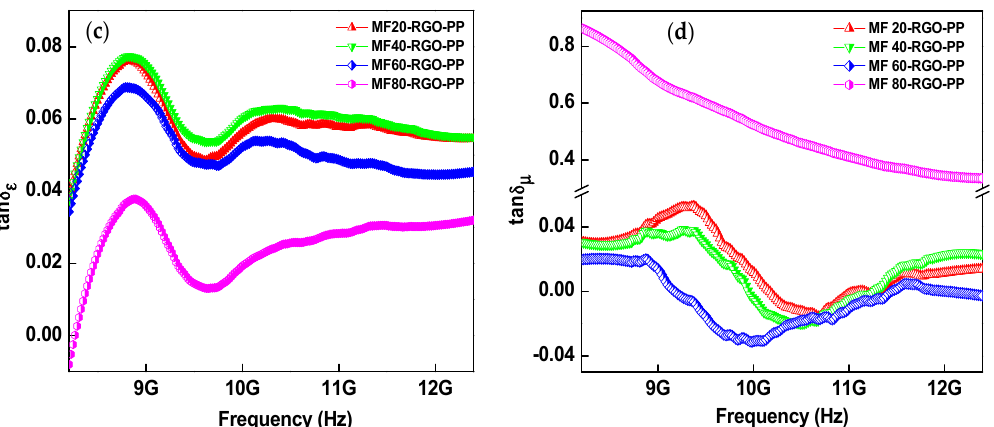
Figure 14. Frequency-dependent ( a ) real part of permeability ( µ ’), ( b ) imaginary part of permeability ( µ ”), ( c ) dielectric loss (tan δ ε ) and ( d ) magnetic loss (tan δ µ ) of prepared MF20-RGO-PP, MF40-RGO-PP, MF60-RGO-PP and MF80-RGO-PP composite samples.